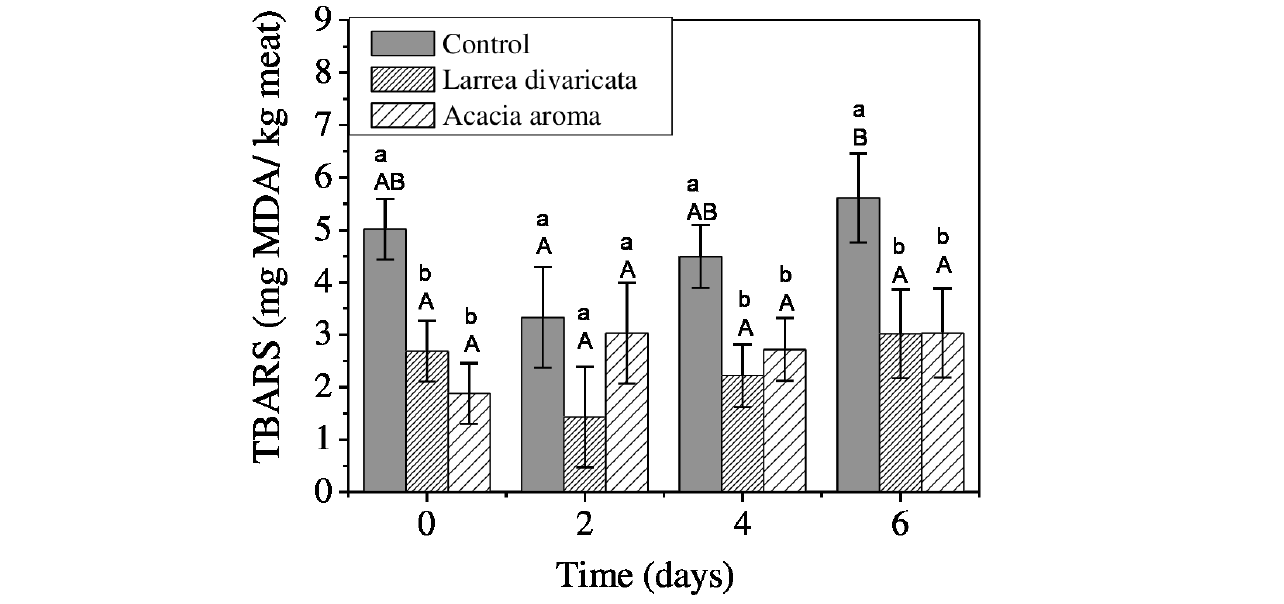
Figure 1. Main effects of dietary treatment and storage time at 4°C on meat oxidative status measured in Longissimus lumborum muscle. Values presented are the mean 2-thiobarbituric acid reactive substances values and standard error bars. a,b Within each day ofstorage, different superscripts indicate differences between dietary treatments and A,B Within each dietary treatment, different superscripts indicate differences among storage days, using LSD Fisher test adjustment for multiple comparisons